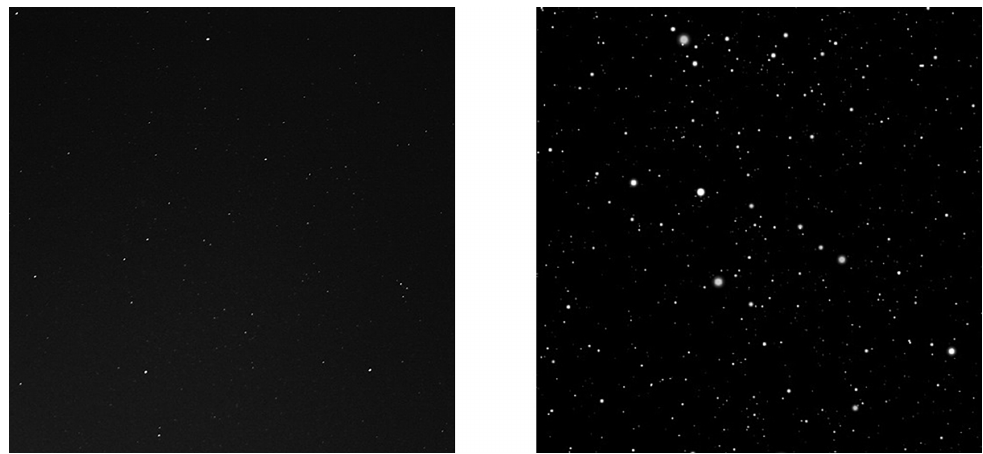
Figure 2. Dataset samples: real night sky image (on the left ) and Stellarium-generated night sky (on the right